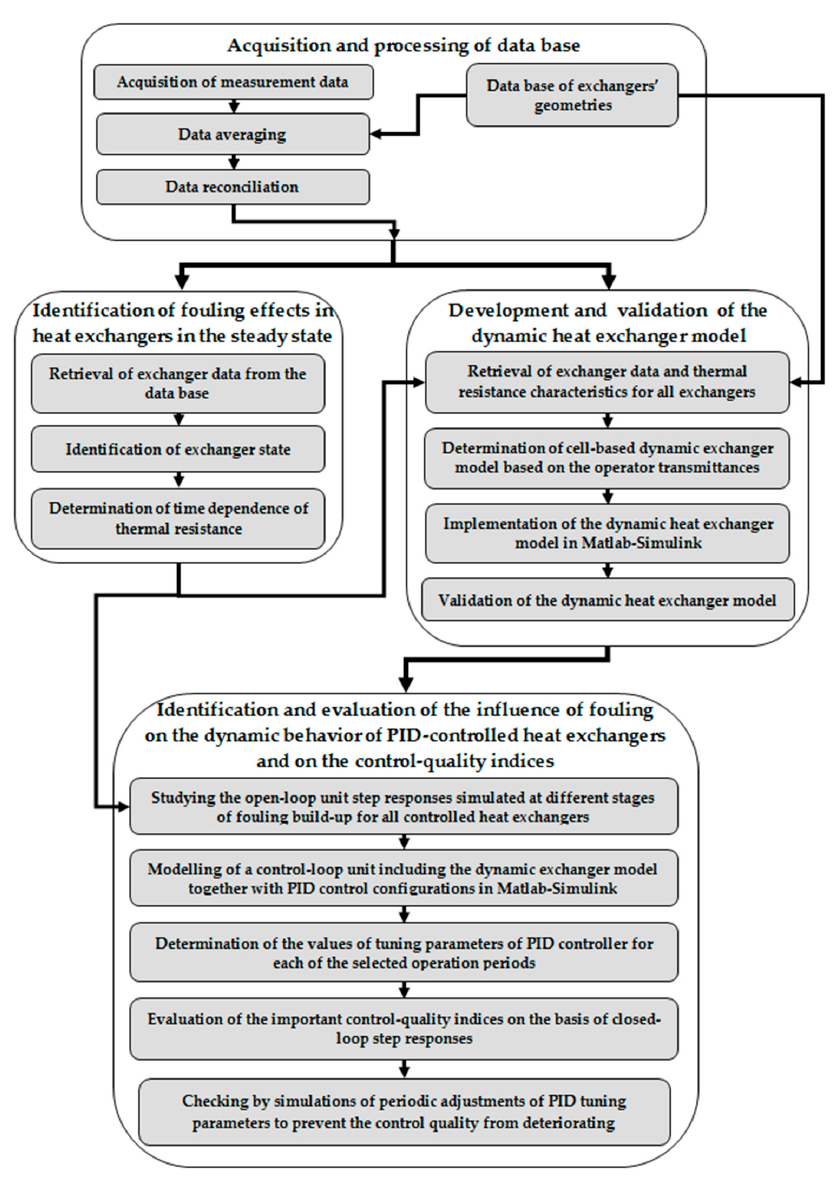
Figure 4. Scheme of the identification and evaluation of fouling influence on the control quality in an industrial